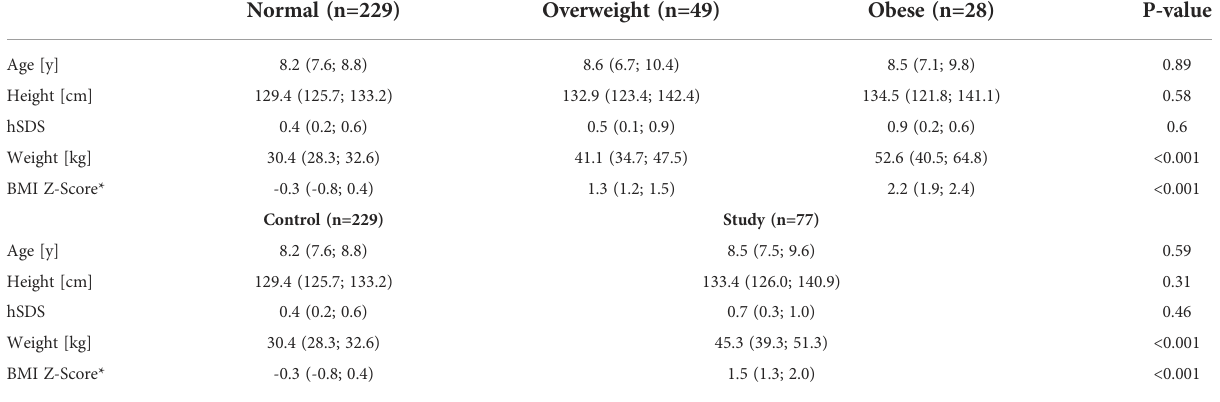
TABLE 3 Anthropometrical data of study